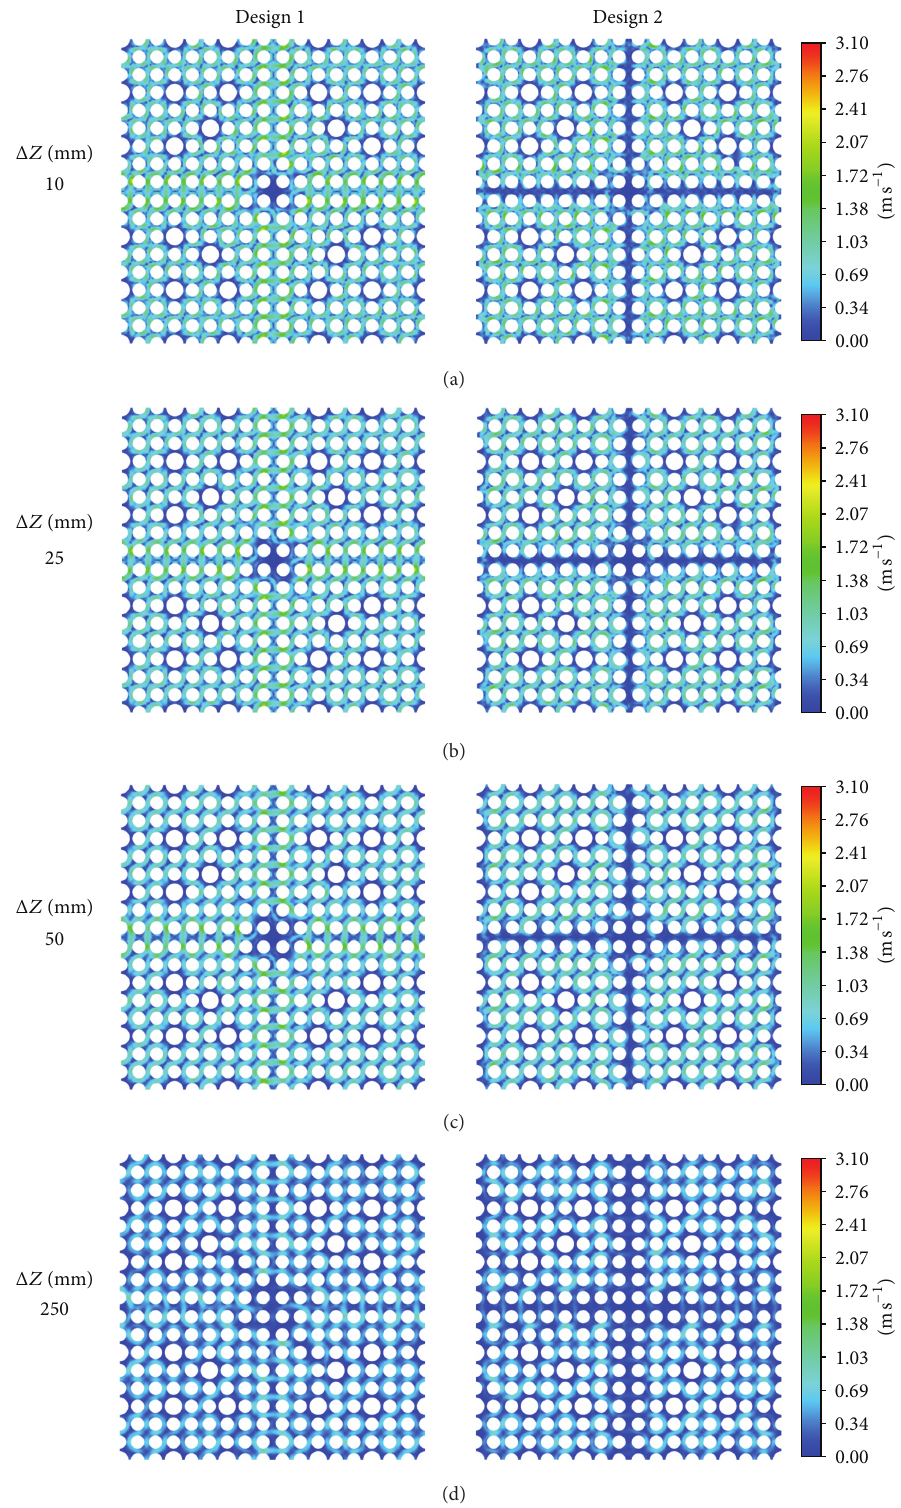
Figure 6: Lateral flow velocity profile ( Δ𝑍 is the distance from grid to the